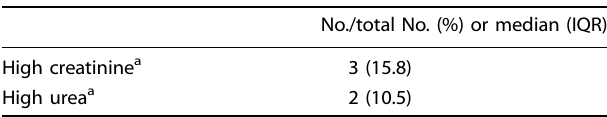
Table 3. Functional recovery of severe